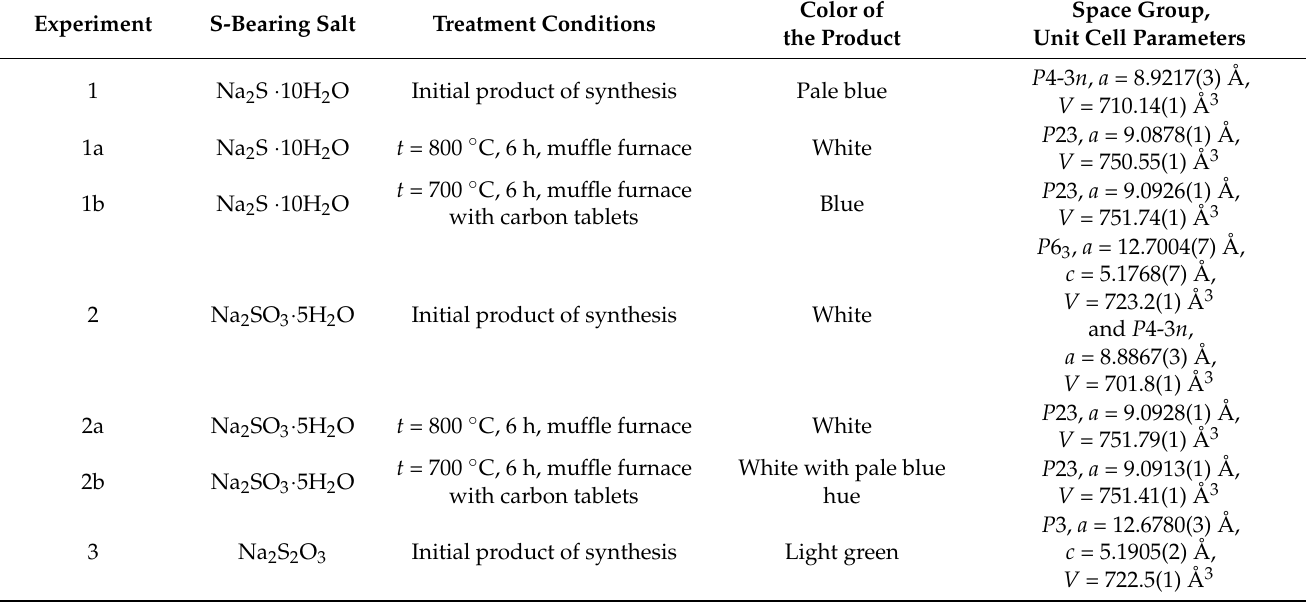
Table 4. Data on the experimental conditions and crystallographic characteristics of the